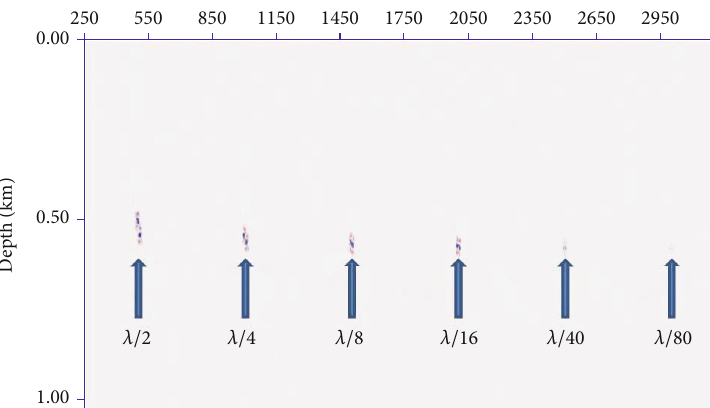
Figure 5: Forward model of the di ff racted wave of di ff erent vertical scales.